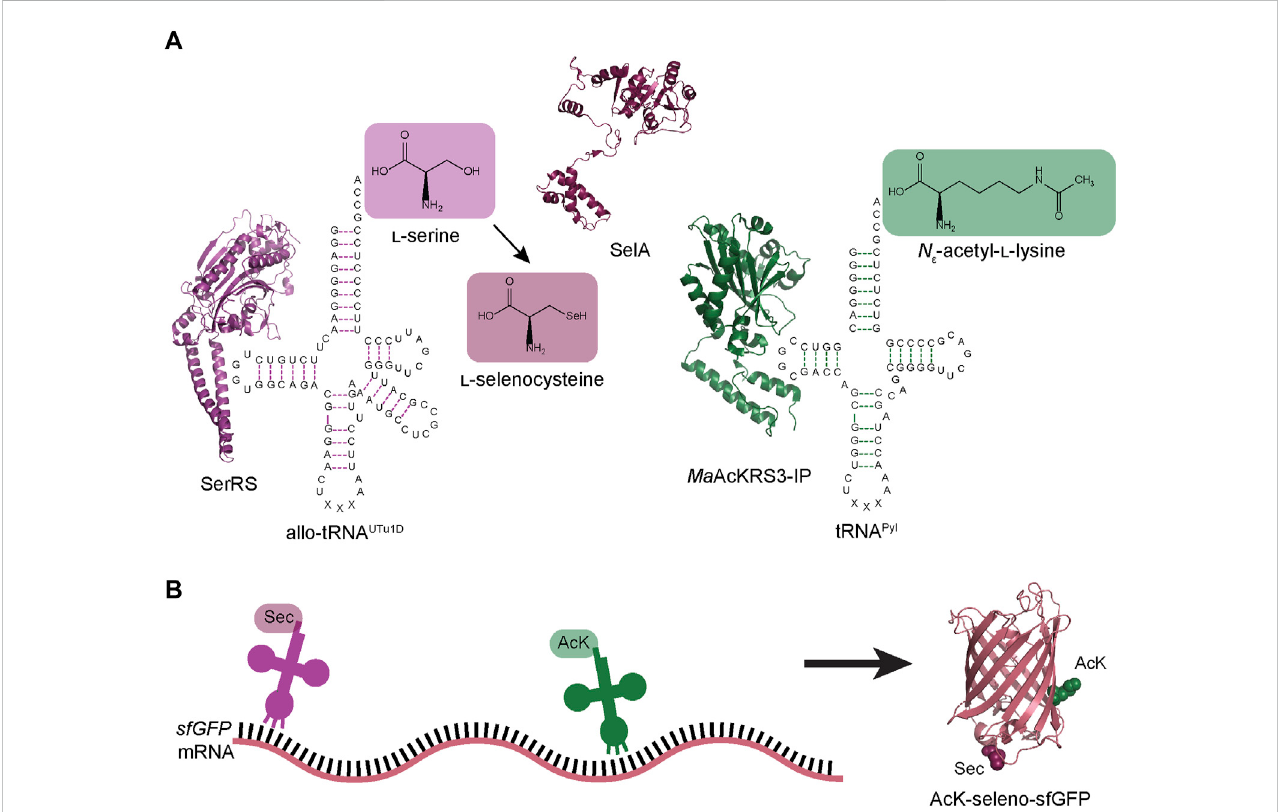
FIGURE 1 Schematic of dual ncAA incorporation to produce post-translationally modi fi ed seleno-sfGFP. (A) Endogenous E. coli seryl-tRNA synthetase (SerRS represented by PDB:1SER) aminoacylates allo-tRNA UTu1D with L -serine, which is then converted to L -Sec by A. salmonicida selenocysteine synthase (SelA represented by PDB:3W1K). M. alvus PylRS containing mutations for recognition of N ε -acetyl- L -lysine (AcK) ( Ma AcKRS3-IP represented by PDB:4Q6G) aminoacylates M. alvus tRNA Pyl . (B) Aminoacylated allo-tRNA UTu1D and tRNA Pyl insert Sec and AcK, respectively, at speci fi c positions in the mRNA. These tRNAs are encoded to suppress stop codons (UAG or UGA), leading to the biosynthesis of AcK-seleno-sfGFP (represented by